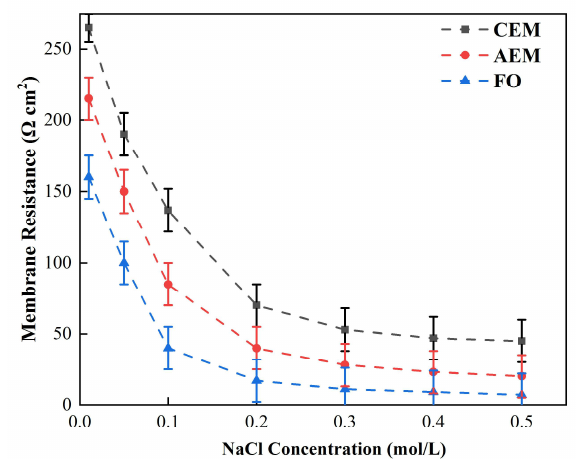
Figure 3. Relationship between the CEM, AEM, and FO membrane impedance and NaCl solution concentration. (The circulation flow rate of the solution was 0.5 L/min under the condition of DC.)